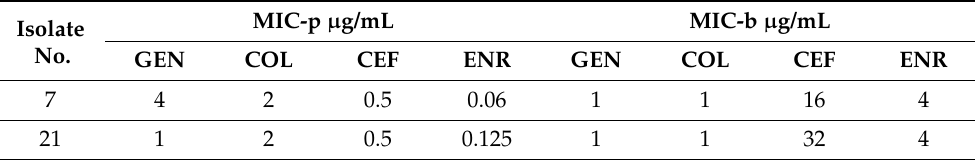
Table 3. MIC-p and MIC-b analysis of selected